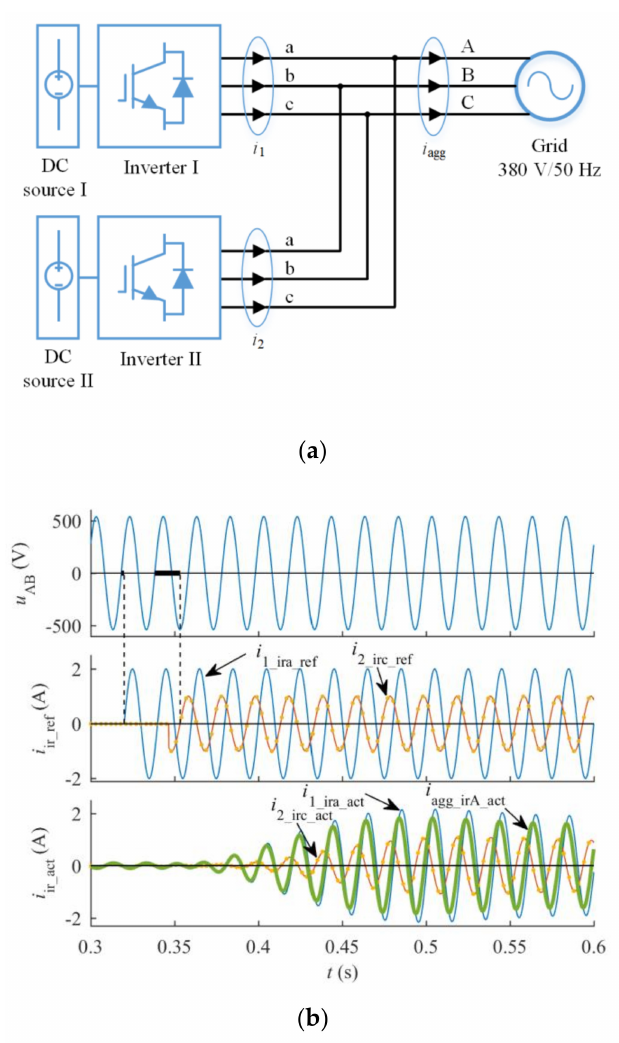
Figure 12. Waveforms under a phase symbol fault. ( a ) Main circuit with a phase symbol fault; ( b ) Negative sequence fundamental frequency current (50